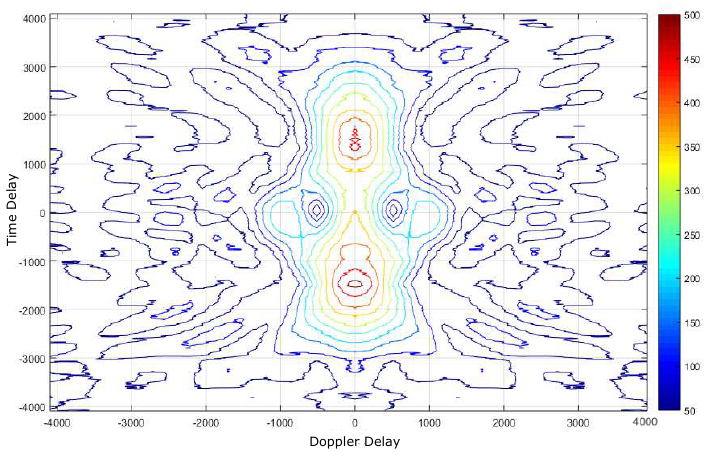
Figure 13. Two nearby scatterers using square pulses, at − 5 dB